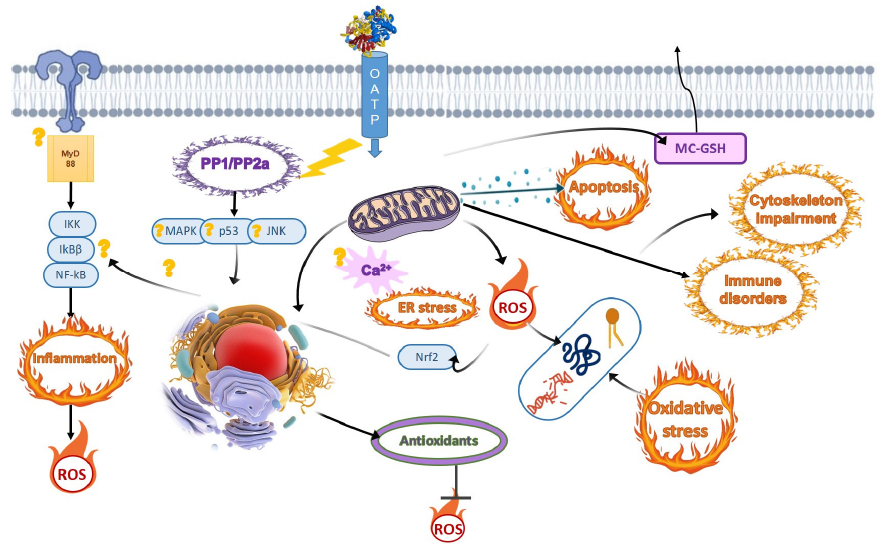
Figure 1. Schematic representation of the cellular and molecular events in fish induced by micro ‐ cystins.